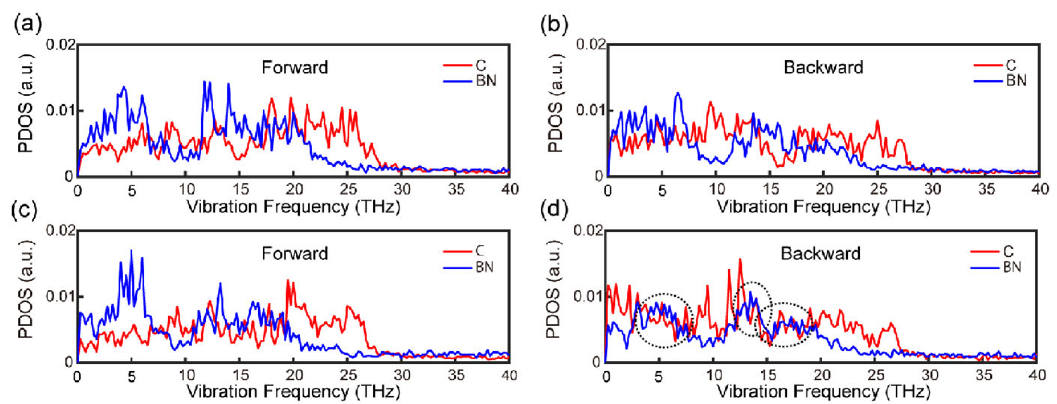
Figure 5. The out-of-plane PDOS curves of carbon and BN atoms at the interface (forward and backward). ( a , b ) Graphene/BN-25 nm; ( c , d ) graphene/BN-100 nm.